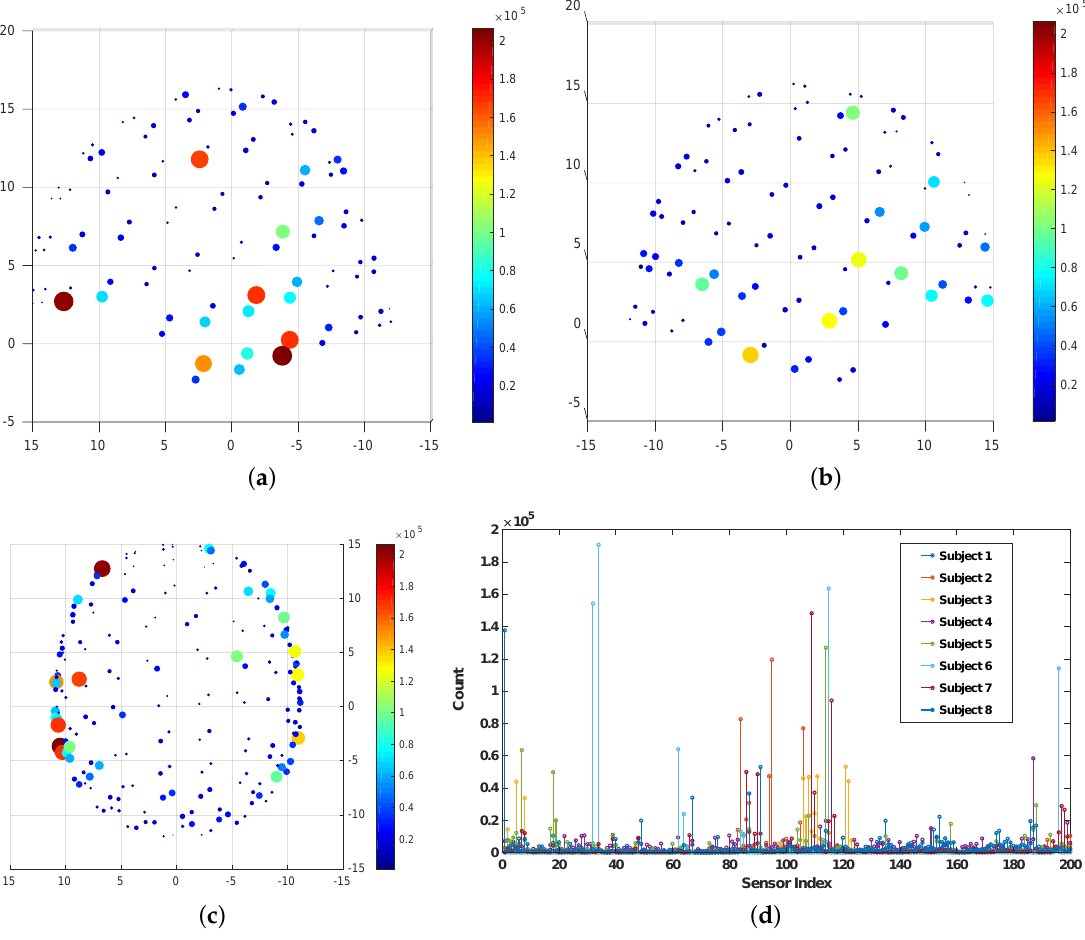
Figure 6. Frequency plot of most active sensors across all 8 subjects shown with 3 views: ( a ) left ( b ) right, and ( c ) axial. Each dot represents a sensor. Color and size represent the count. ( d ) represents a histogram plot of the frequency (count) of all the active sensors for each subject individually represented by a unique